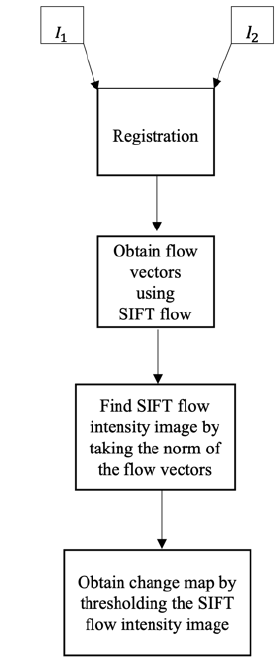
Figure 3. Flow chart for change detection using SIFT